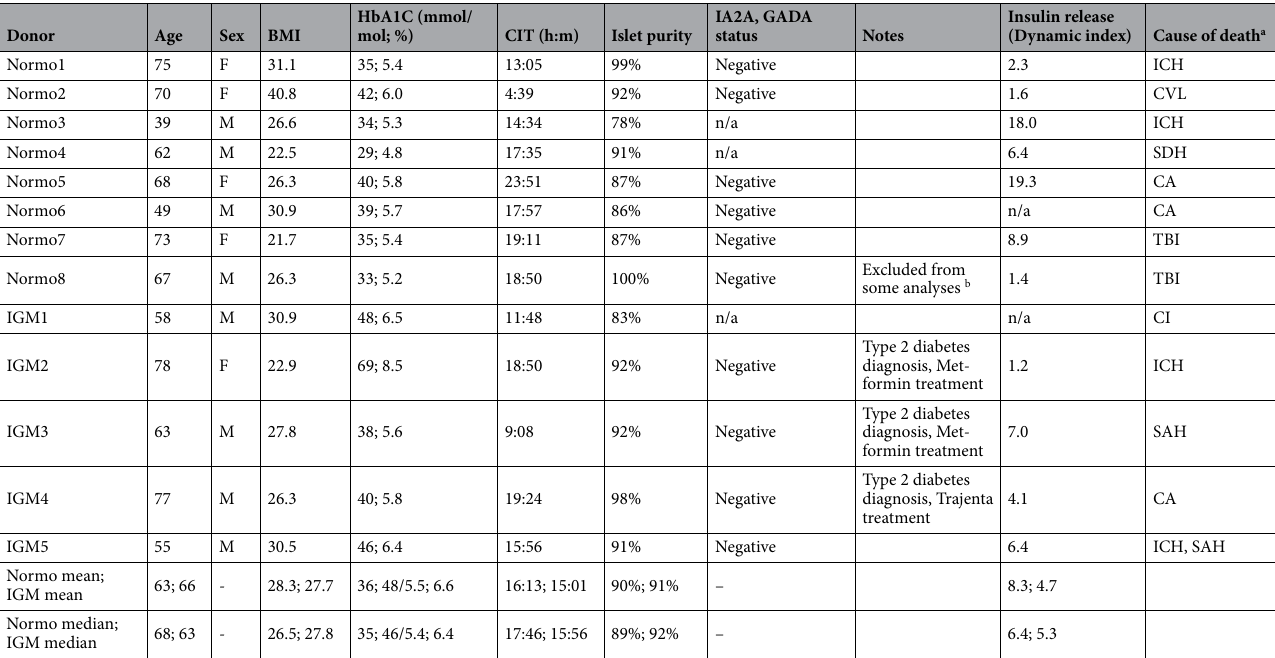
Table 1. Organ donor data. CIT, Cold Ischemia Time. IA2A, insulinoma-associated protein 2 autoantibody. GAD glutamic acid decarboxylase autoantibody, ICH intracerebral hemorrhage, CVL cerebrovascular lesion,